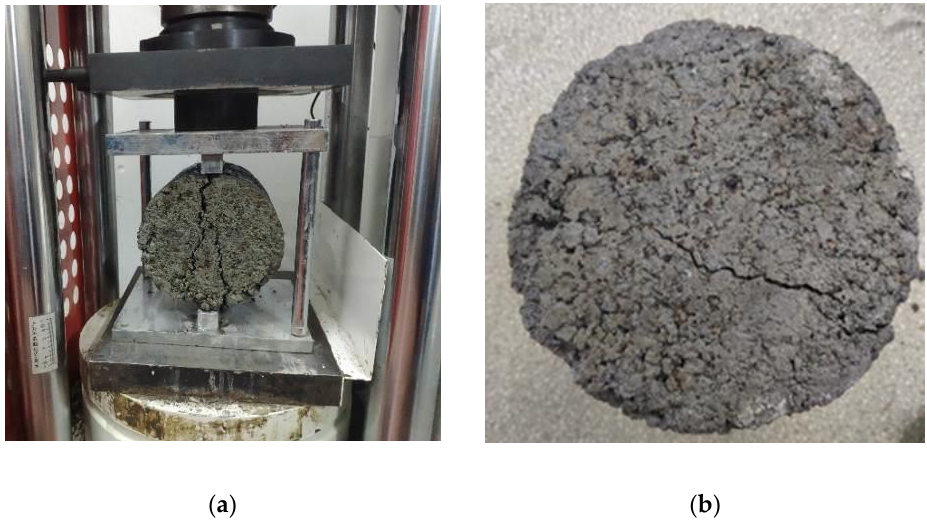
Figure 3. Splitting tensile-strength test: ( a ) test setup; ( b ) test specimen.